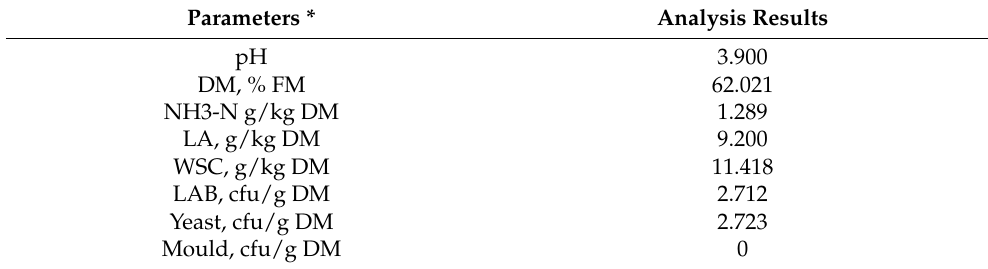
Table 1. Chemical and microbiological analysis results for the beginning material (day 0).